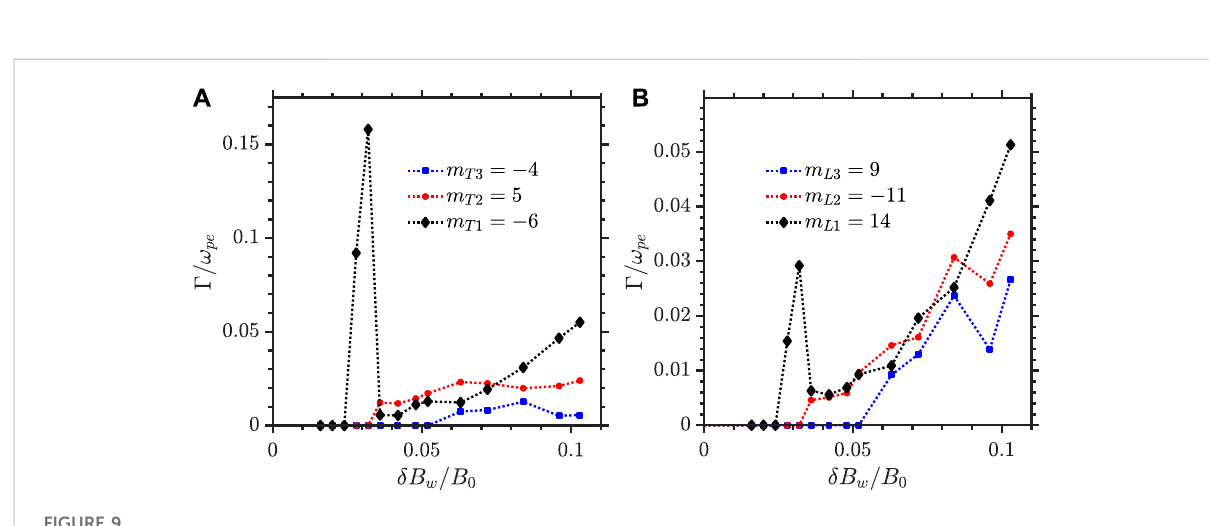
Growth rates of whistler and IAW modes as the pump amplitude, δ B P / B 0 , increases show clear transitions between single, double and triple decay (A) Whistler modes. (B) IAW